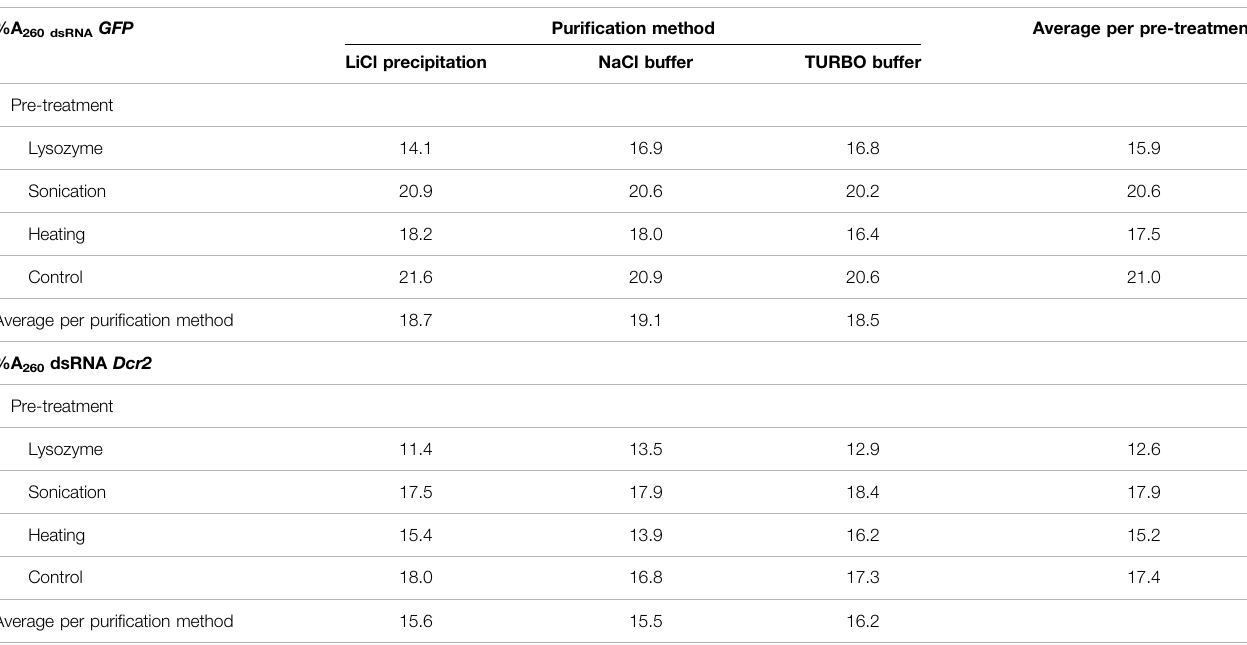
TABLE 1| PercentageofA 260 unitsretainedafter treatmentoftotalRNA(%A 260dsRNA )from dsGFP or dsDcr2 producing bacteriaforallcombinationsofpre-treatments and puri fi cation methods tested. %A 260 dsRNA